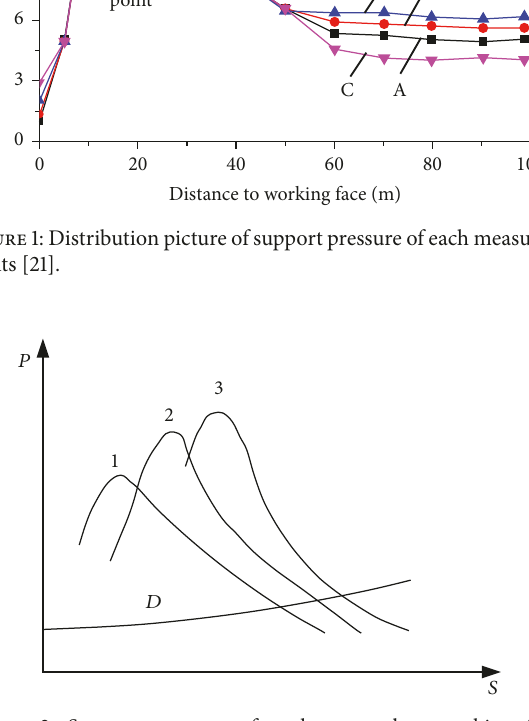
Figure 2: Support pressure of coal seam when working face advancing